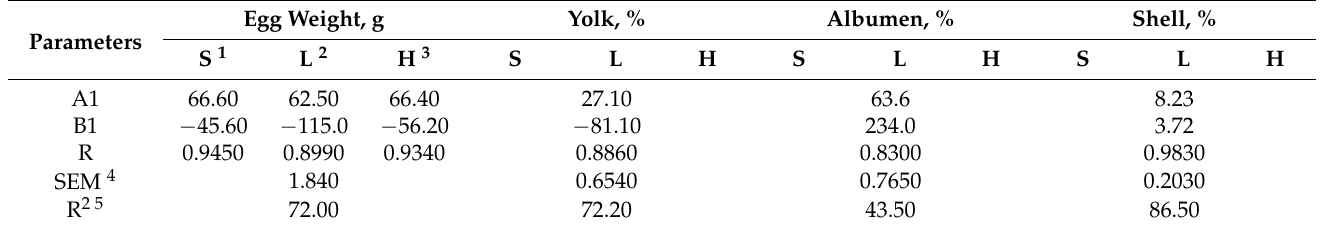
Table 11. Coefficients for the exponential equation for egg weight and egg components of laying hens from 19 to 102 weeks old in response to age for three dietary balanced protein